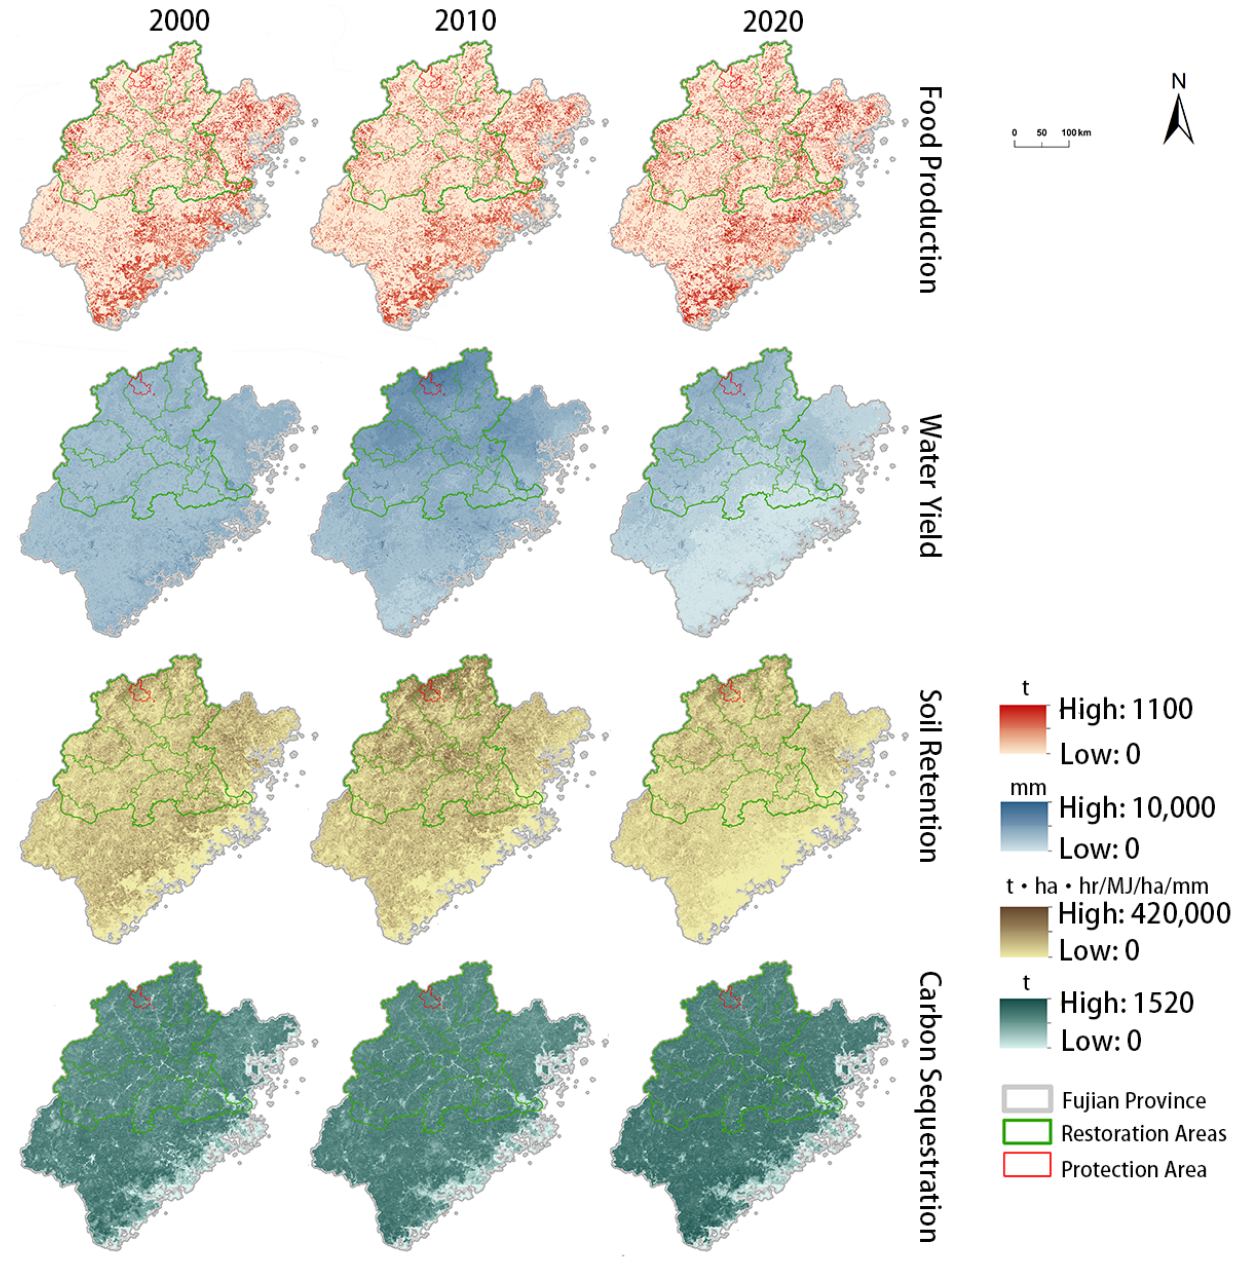
Figure 2. Variation in the ecosystem services supply in the Fujian Province. From 2000 to 2020, the supply of FP and CS increased, and WY and SR decreased in the Fujian Province (Table 3). The FP in each region decreased between 2000 and 2010 and increased between 2010 and 2020, with the largest changes in protected areas occurring during these two time periods. CS in the protection area decreased from 2000 to 2010 and increased in the other regions in both time periods. SR services showed an increasing and then decreasing trend in both protection and restoration areas, while they continued to decrease in other areas. The change rate was greatest in protected areas in these two time